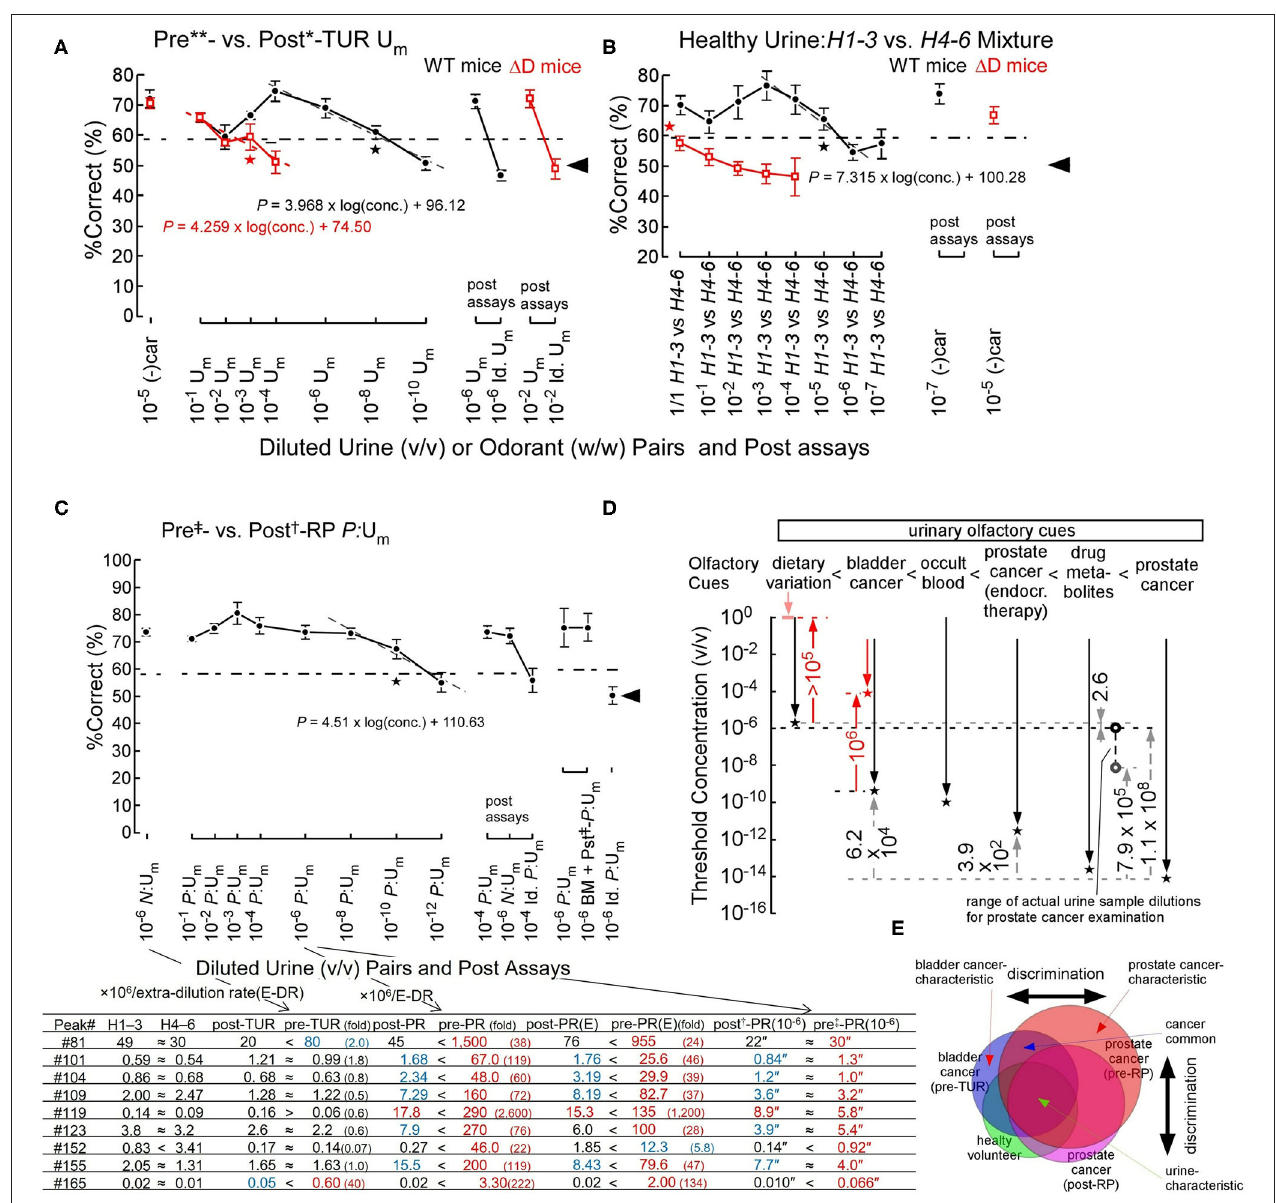
FIGURE 2 | Odor discrimination thresholds of wild-type (WT) and 1 D mice for bladder and prostate cancers and healthy volunteer dietary variation (Sato et al., 2017, 2021). (A) Odor discrimination of WT (black closed circles) and 1 D mice (red open squares) between equi-occult blood pre**- vs. post*-transurethral resection (post*-TUR) urine mixture (U m ) of five patients with bladder cancer (Sato et al., 2017). 1 D mice showed a marked elevation of discrimination threshold for bladder cancer odor (pre-TUR odor) vs. post-TUR odor. Post-assays, 10 − 6 pre**- vs. post*-TUR U m and identical U m pair: 10 − 6 pre**- vs. pre**-TUR U m . The percent correct (%Correct) for a training odor pair − 10 − 5 R-(–) carvone [(–)car] (w/w) vs. solvent [di(propylene)glycol] just before the urine discrimination assay is shown on the left side. Linear regression models are shown around the thresholds (gray or red dashed lines). Two alternative forced choice assays with target vs. non-target odors were performed in a Y-maze. Tasks performed at thresholds are marked by the star. Chain lines indicate the %Correct significantly above chance performance ( P = 0.05). Black arrowheads indicate chance levels (50%). (B) Urine odor discrimination between a pair of healthy ( H ) urine mixtures—six volunteers’ 1 st -3 rd sample ( H 1–3) vs. 4 th -6 th sample ( H 4–6) U m . 1 D mice could not discriminate the healthy volunteer urine pair. Post assays: 10 − 7 and 10 − 5 (–)car vs. solvent for WT and 1 D mice, respectively. (C) Odor discrimination of sniffer mice between equal-occult blood pre ‡ - vs. post † -radical prostatectomy (post † -RP) U m of five patients with prostate cancer (Sato et al., 2021). Post-assays, 10 − 4 P :U m pair: 10 − 4 pre ‡ - vs. post † -RP P :U m , 10 − 6 N :U m pair: pre**- vs. post*-TUR of bladder cancer N :U m and identical P :U m pair: 10 − 4 pre ‡ - vs. pre ‡ -RP P :U m . The percent correct (%Correct) for a training odor pair − 10 − 6 N :U m pair just before the prostate cancer urine discrimination assay is shown on the left side. On the right side, the identical %Correct between pairs of pre ‡ - vs. post † -RP U m and post ‡ -RP + biomarker (BM) U m (prostate cancer odor mimic) vs. post † -RP U m , and by chance choice for identical pre ‡ -RP U m pair are shown. Extra-dilution rates for equal-occult blood U m s are 1/13** v/v, 1/6* v/v, 1/50 ‡ v/v, and 1/2 † v/v. The lower panel shows concentrations (ppb) (-fold of healthy control) of respective peak compounds in the respective original samples, and concentration ′′ (ppq) in the (10 6 × extra rate)-fold diluted urine samples. (E) After neoadjuvant endocrine therapy. “ ≈ ” means < 2 ratios of paired sample